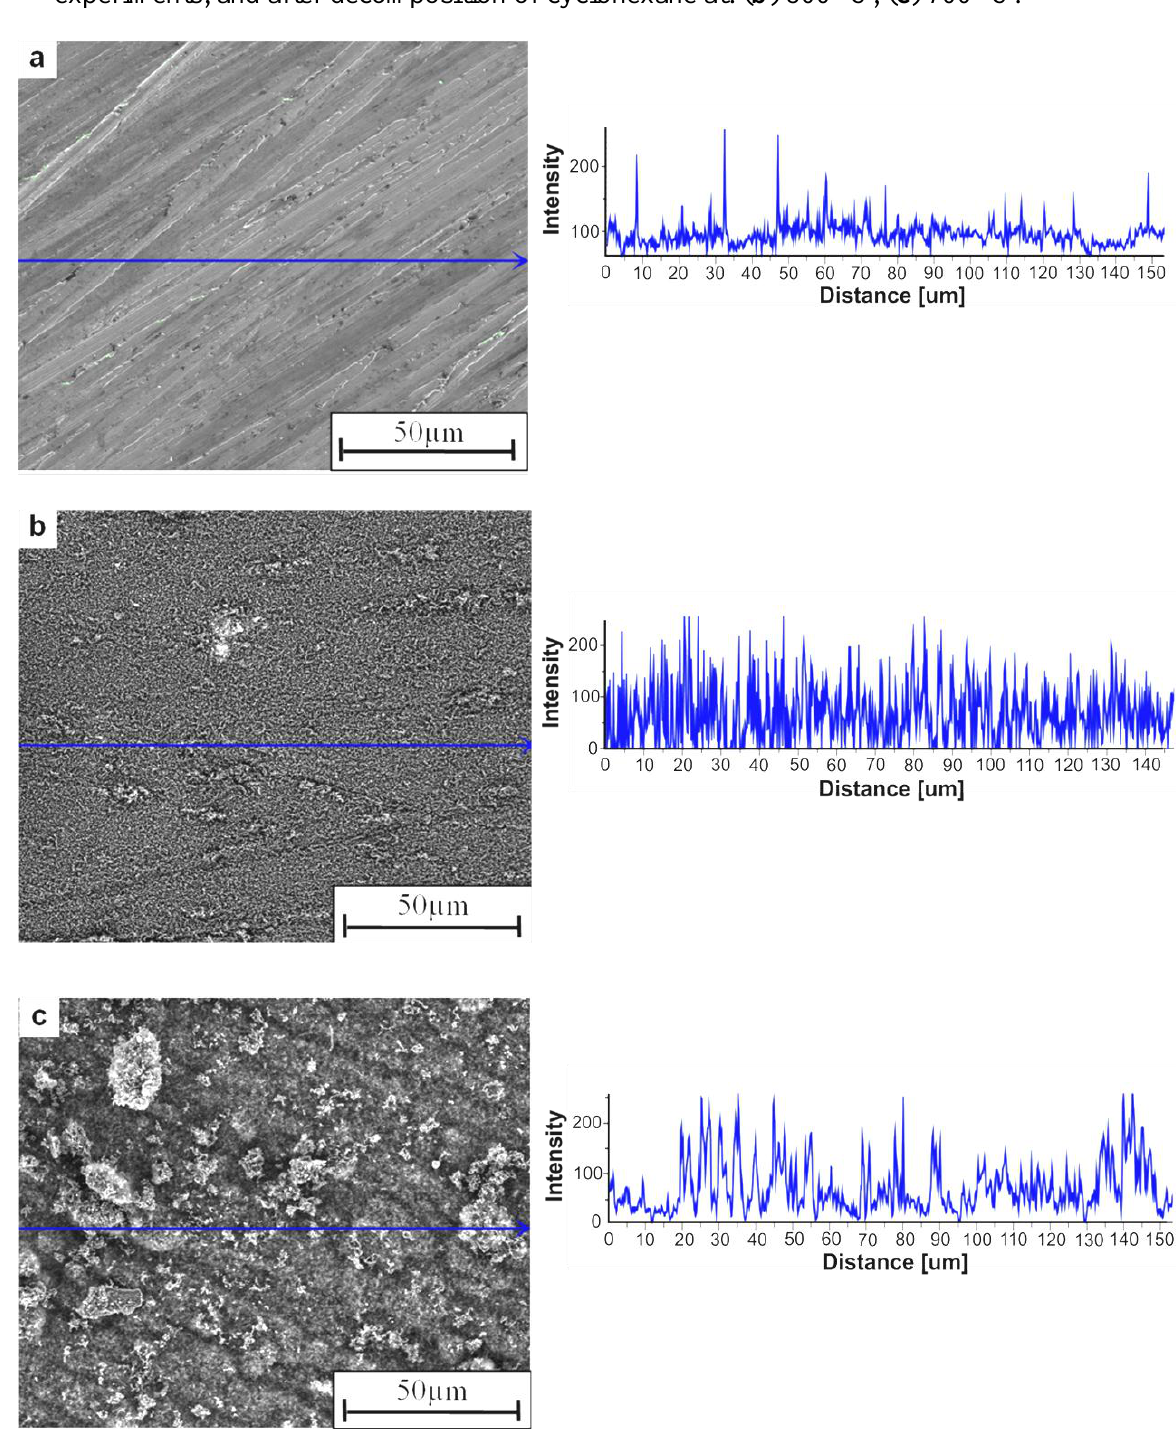
Figure 2. SEM morphology with intensity profiles of the surface of Ni 3 Al foil: ( a ) before experiments; and after decomposition of cyclohexane at: ( b ) 500 °C; ( c ) 700